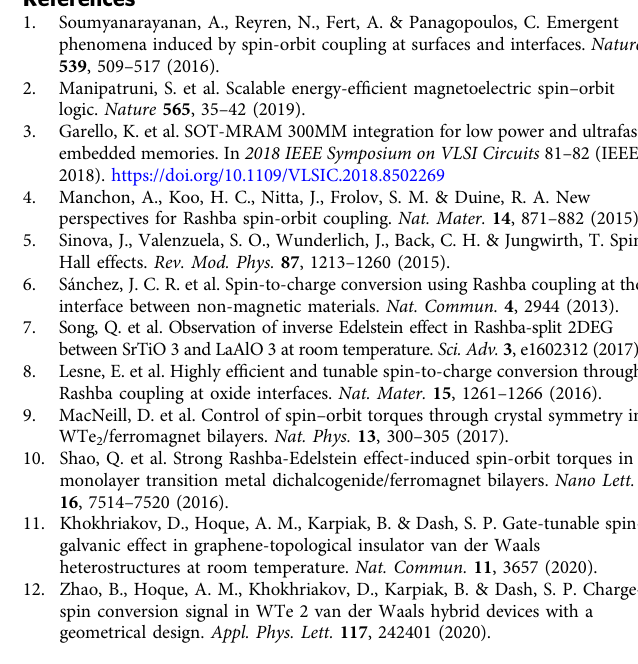
authors on reasonable request.